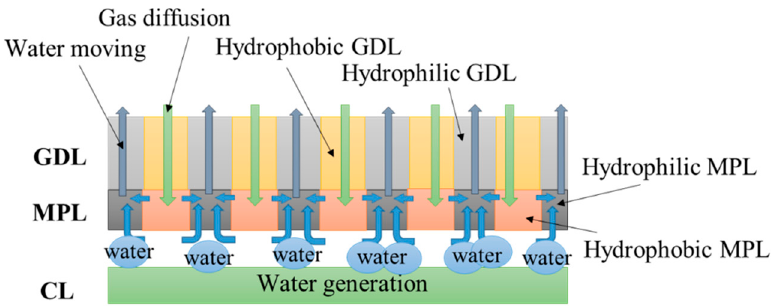
Figure 1. Schematics of structure and functions of the dual hybrid microporous layer (H-MPL) & gas diffusion layer (GDL).